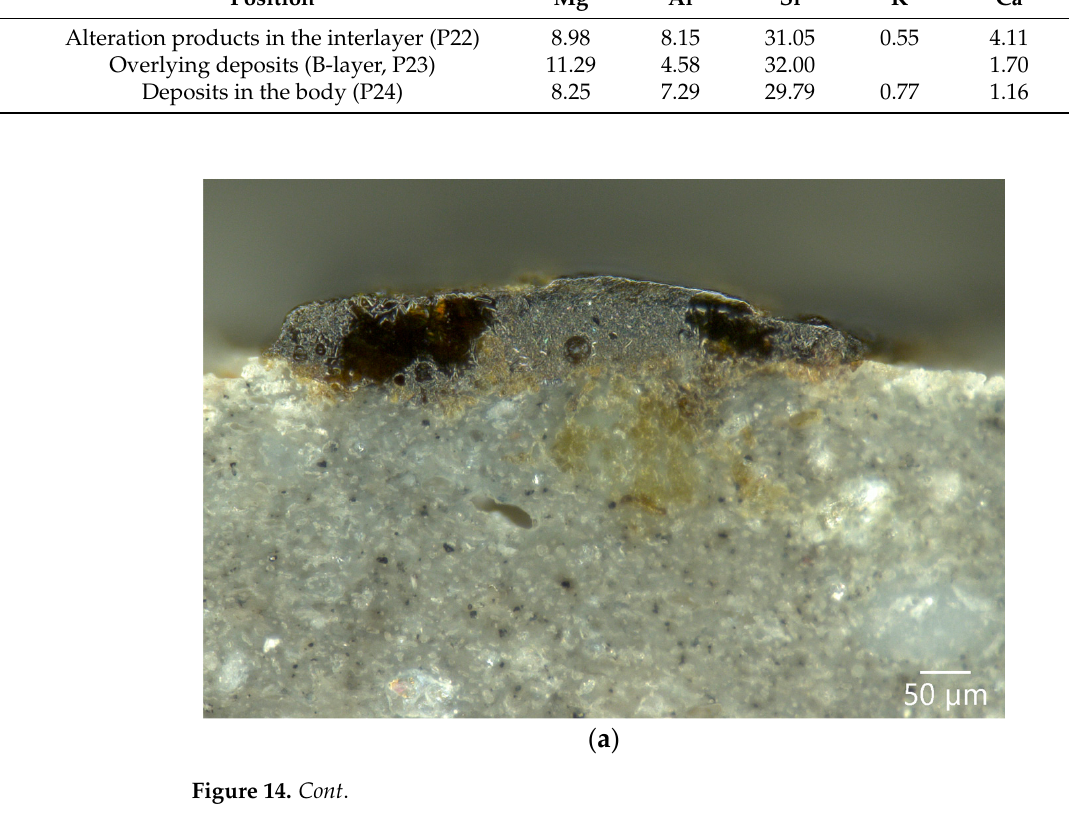
( b ) ( c ) Figure 14. Cross-sectional morphology and element mapping image at the position of residual glaze of sample DL-1: ( a ) OM image, ( b ) SEM image, and ( c ) element mapping images.